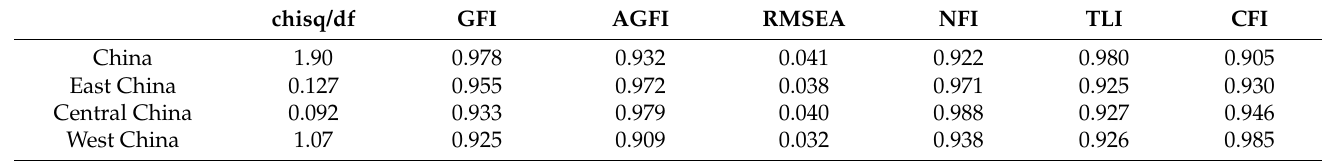
Table 5. Model fitting results for different regions.